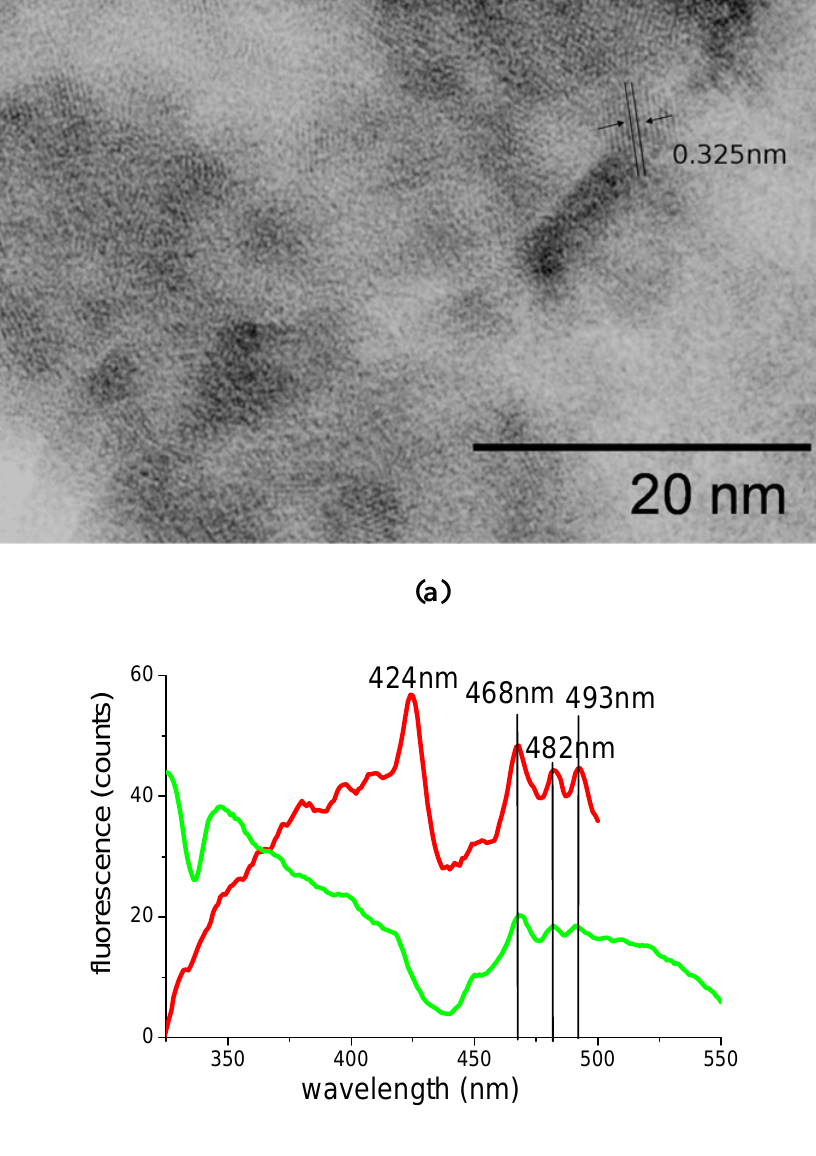
Figure 10. TEM image (a) and fluorescence spectra (b) of PAMAM G5-capped CdSe QDs. Excitation of the fluorescence is obtained with 270 nm (red curve) or 300 nm (green